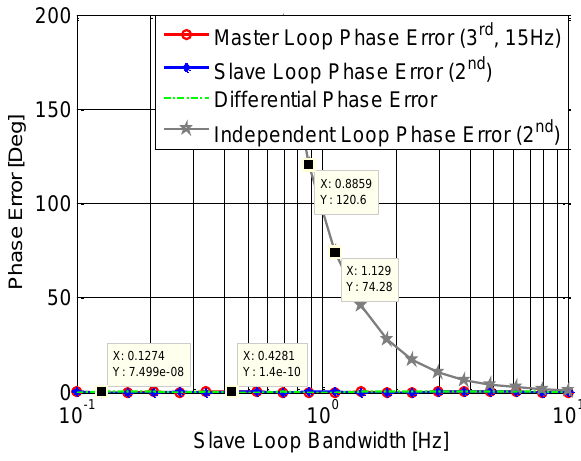
Figure 6. Phase jitter induced by dynamic.